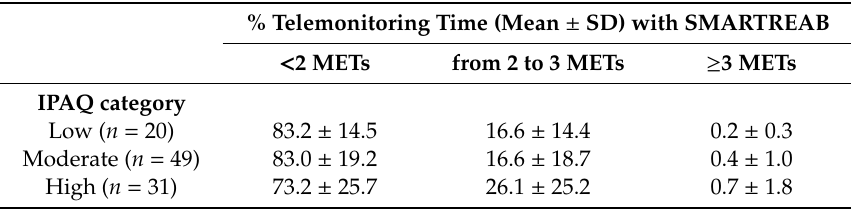
Table 4. Subjective IPAQ and objective SMARTREAB PADL assessments.